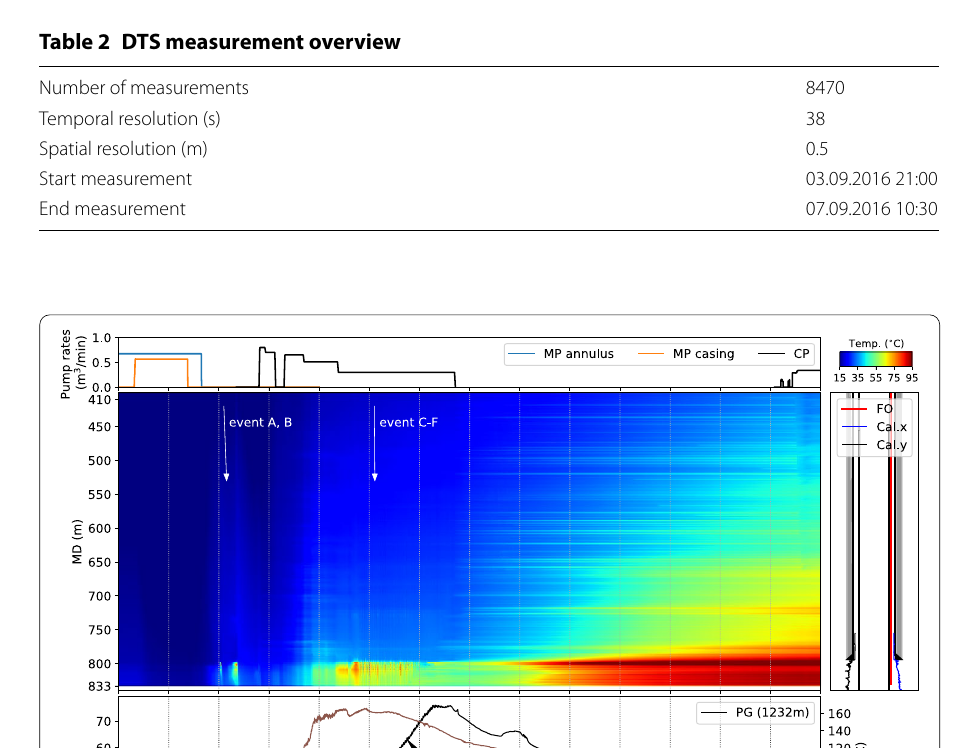
Measurement overview